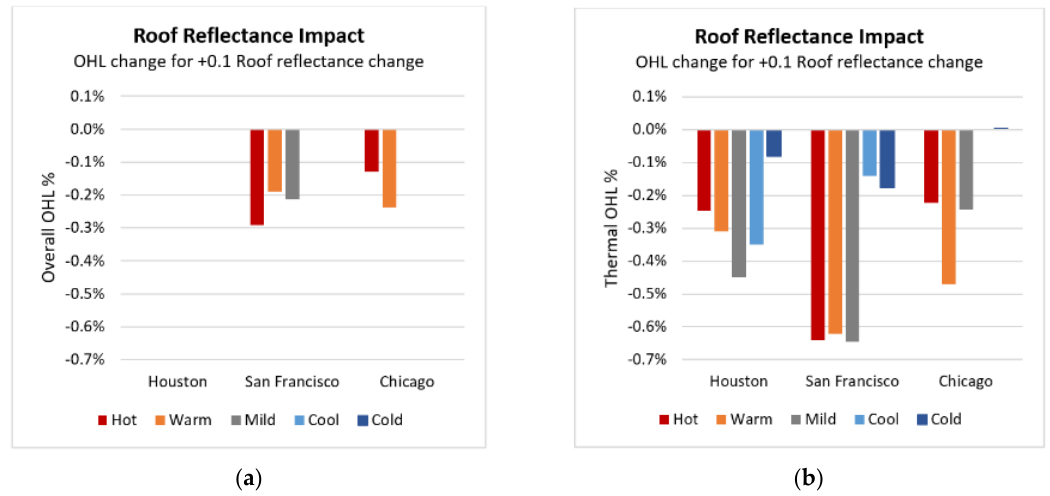
Figure 13. Impact of a 0.1 increase in roof reflectance on overall ( a ) and thermal ( b ) OHL.